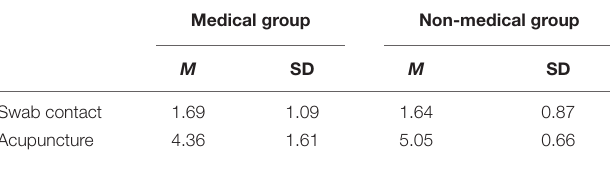
TABLE 2 | Pain evaluation scores in the medical and non-medical groups.